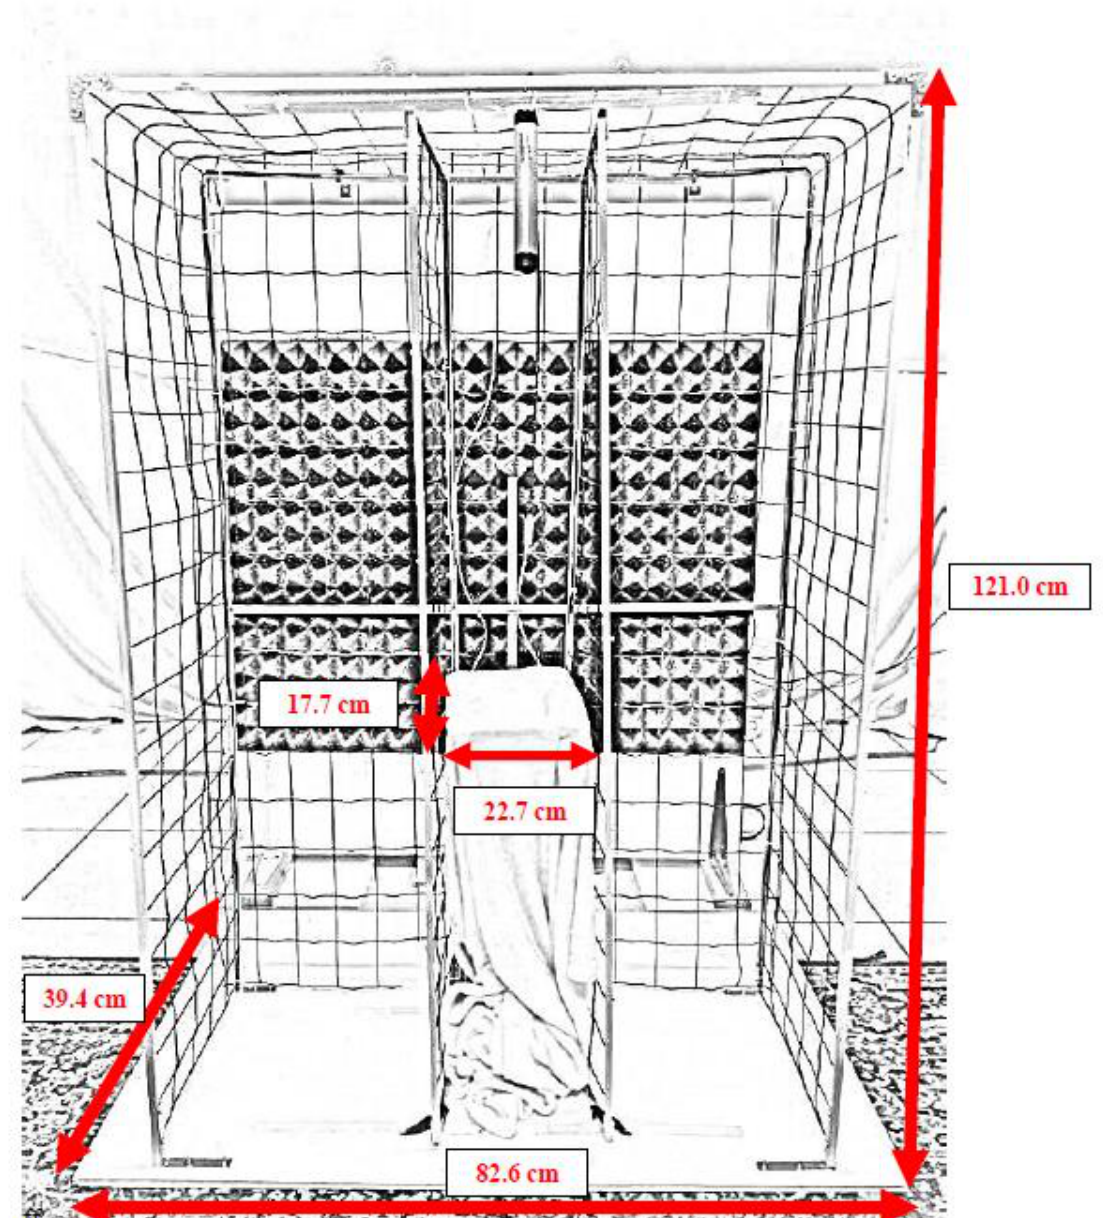
Figure 2. Detailed picture of the apparatus.